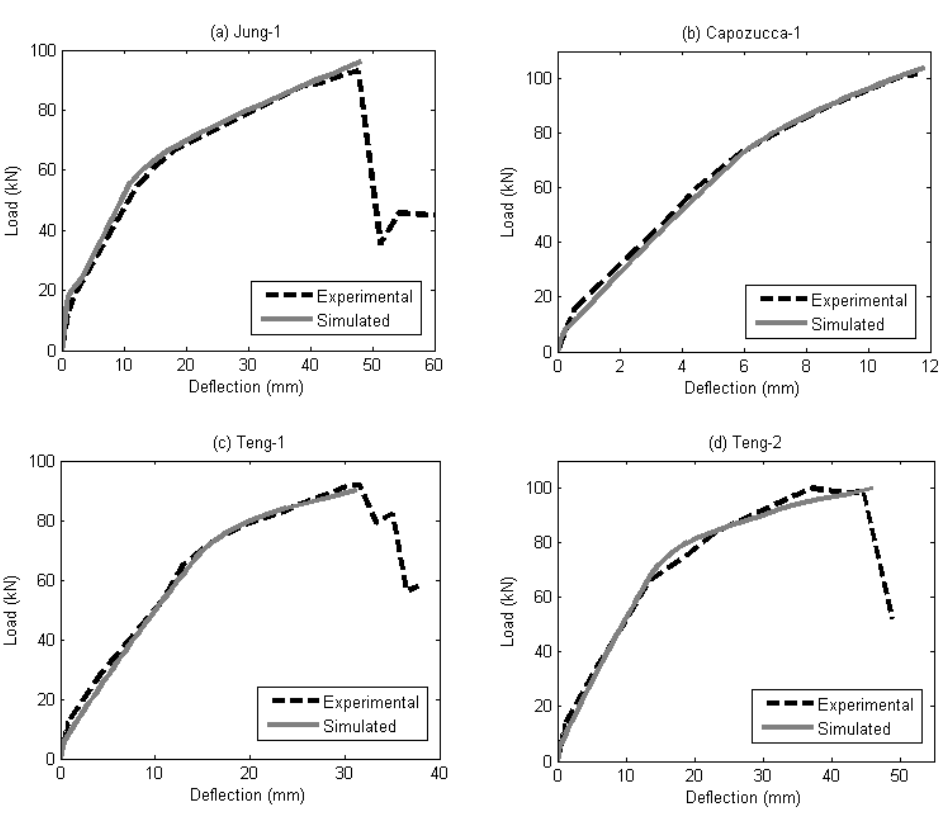
Figure 12. Comparison of experimental and simulated load-deflection of beams ( a ) Jung-1; ( b ) Capozucca-1; ( c ) Teng-1; and ( d )